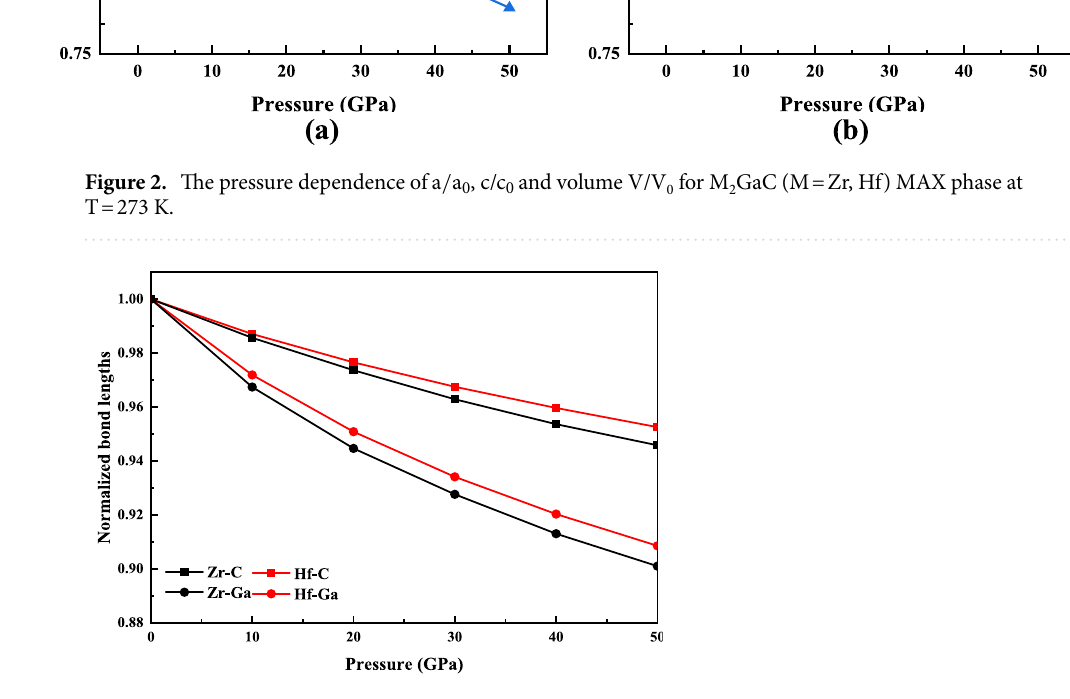
Figure 3. Variation of normalized bond lengths between M–Ga and M–C atoms of M 2 GaC (M = Zr, Hf) MAX phase with pressure.